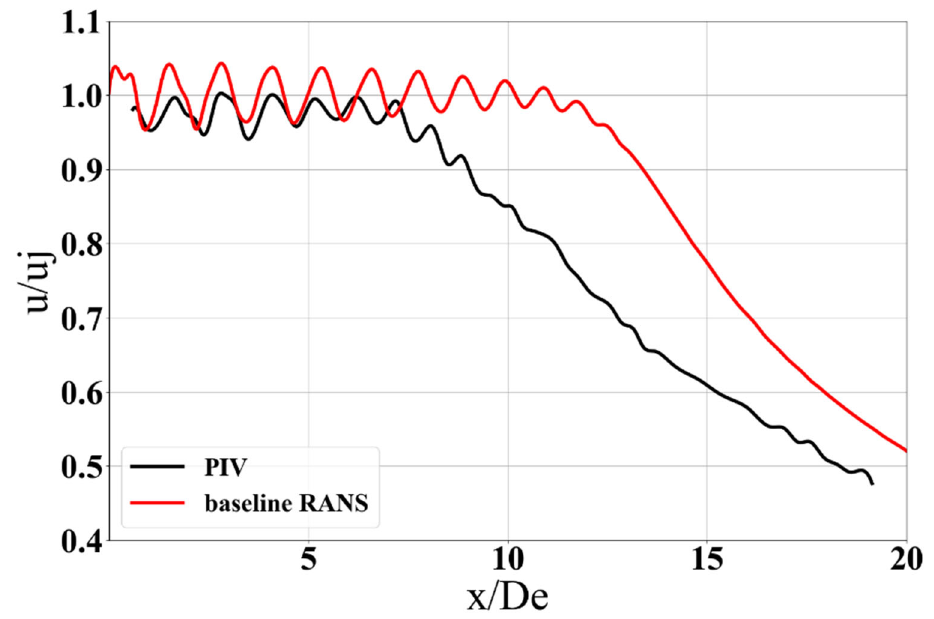
Figure 2 . Centerline velocity comparison for baseline RANS with PIV data [60]. Figure 2. Centerline velocity comparison for baseline RANS with PIV data